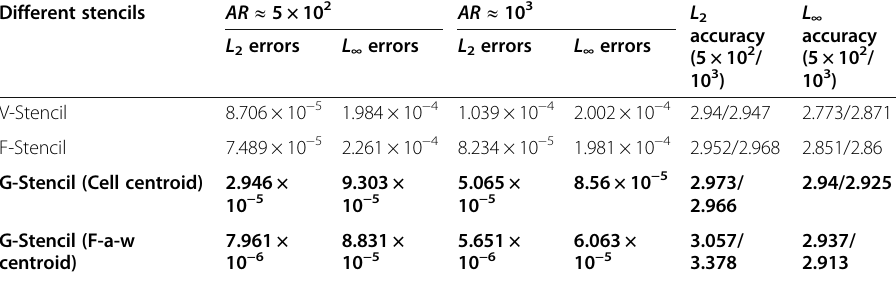
Table 11 Computational errors on the finest grid and L 2 , L ∞ accuracy between the last two grids of different stencils Different